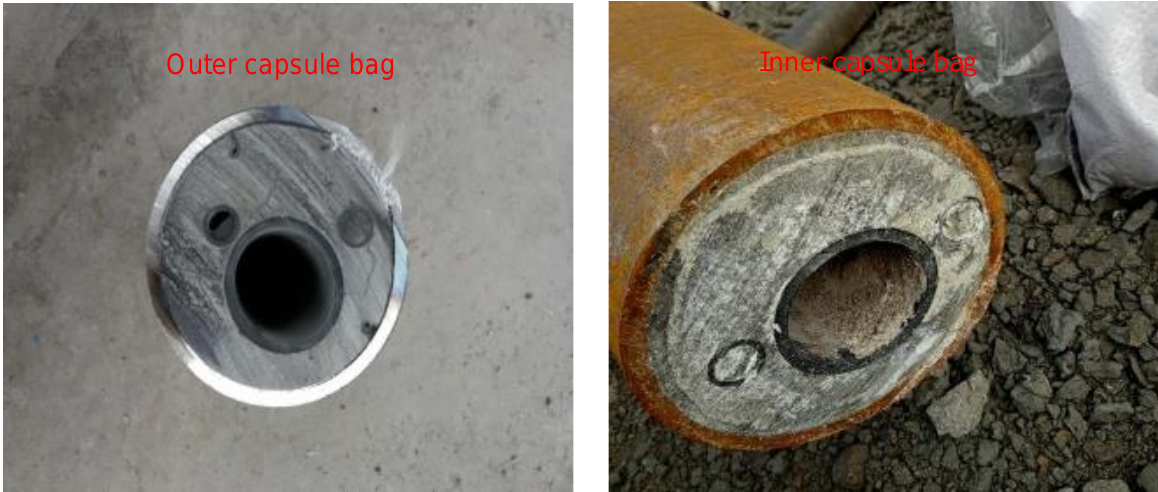
Figure 15. Borehole profile of boreholes for “Two plugs, one injection and one row” .